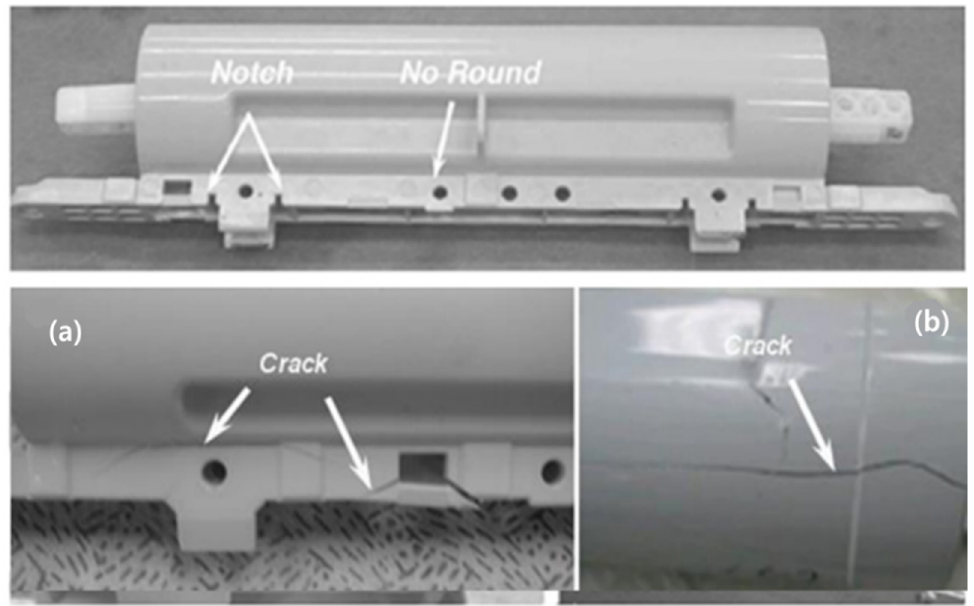
Figure 9. Failed HKS from the marketplace and in the first ALT: ( a ) Failed product after first ALT; ( b ) product with crack in field.